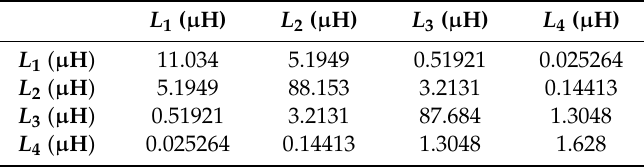
Table 7. Self- and mutual- inductance between coils.